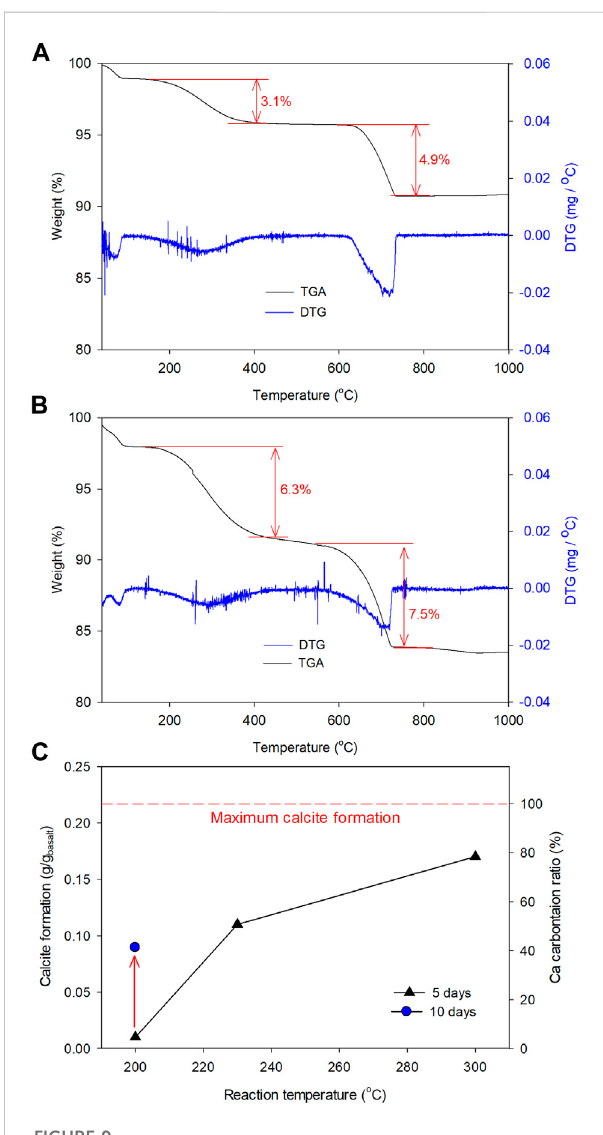
FIGURE 9 TG analysis results of solid samples collected after hydrothermalreaction of basalt in 0.5 mol/L NaHCO 3 solution at (A) 230 ° C and (B) 300 ° C for 5 days, and (C) calcite formation during the alteration of basalt. “ Maximum calcite formation ” refers to the amount of CaCO 3 formed when all the Ca contained in the initial basalt (CaO: 12.16 wt%) was carbonated to CaCO 3 , which is 0.217 g/g of basalt in this